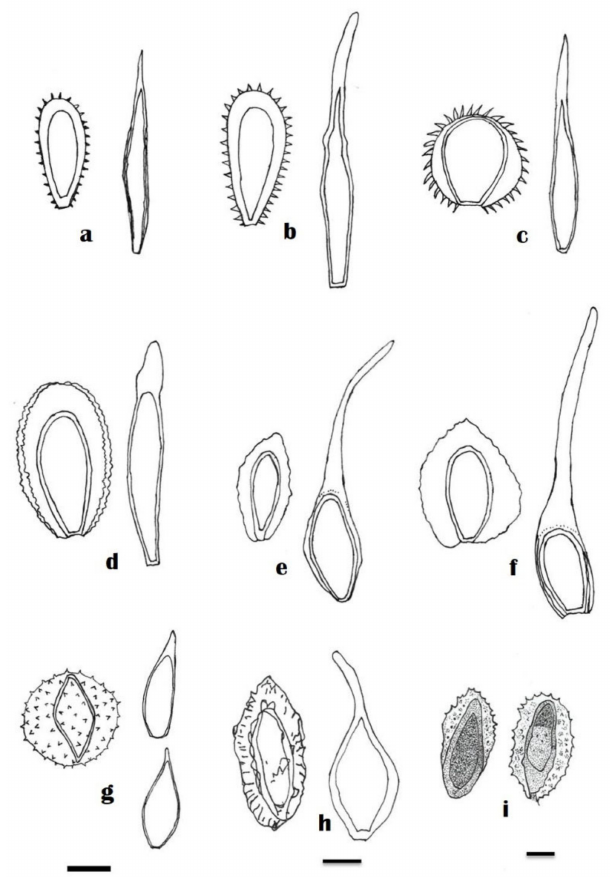
Figure 4. Uredospores and teliospores (line diagrams) different Skierka spp. ( a ) S. congensis Henn; ( b ) S. philippinensis Mains; ( c ) S. canarii Racib; ( d ) S. cristata Mains; ( e ) S. petchii (Syd.) Mains; ( f ) S. holwayi Arthur; ( g ) S. nephelii S. Ito and Muray; ( h ) S. divinopolensis Dianese; ( i ) S. agallochae Racib. Redrawn references [20,25,28,31,34]. Scale bars = 20 µ